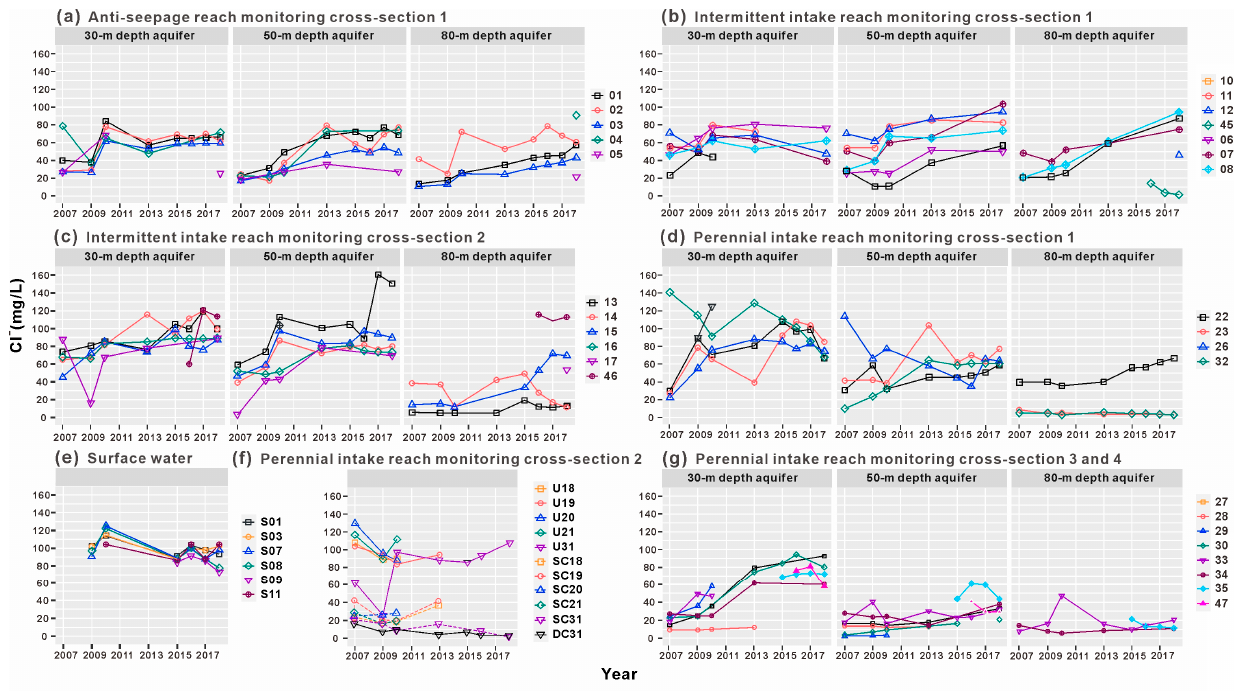
Figure 5. Variations in the Cl − concentrations of the water samples before (September 2007) and after (March or May 2009–2018) reclaimed water replenished to the Chaobai River. ( a ) groundwater at Anti-seepage reach monitoring cross-section 1, ( b ) groundwater at Intermittent intake reach monitoring cross-section 1, ( c ) groundwater at Intermittent intake reach monitoring cross-section 2, ( d ) groundwater at Perennial intake reach monitoring cross-section 1, ( e ) surface water ( f ) groundwater at Perennial intake reach monitoring cross-section 2, ( g ) groundwater at Perennial intake reach monitoring cross-section 3 and 4.